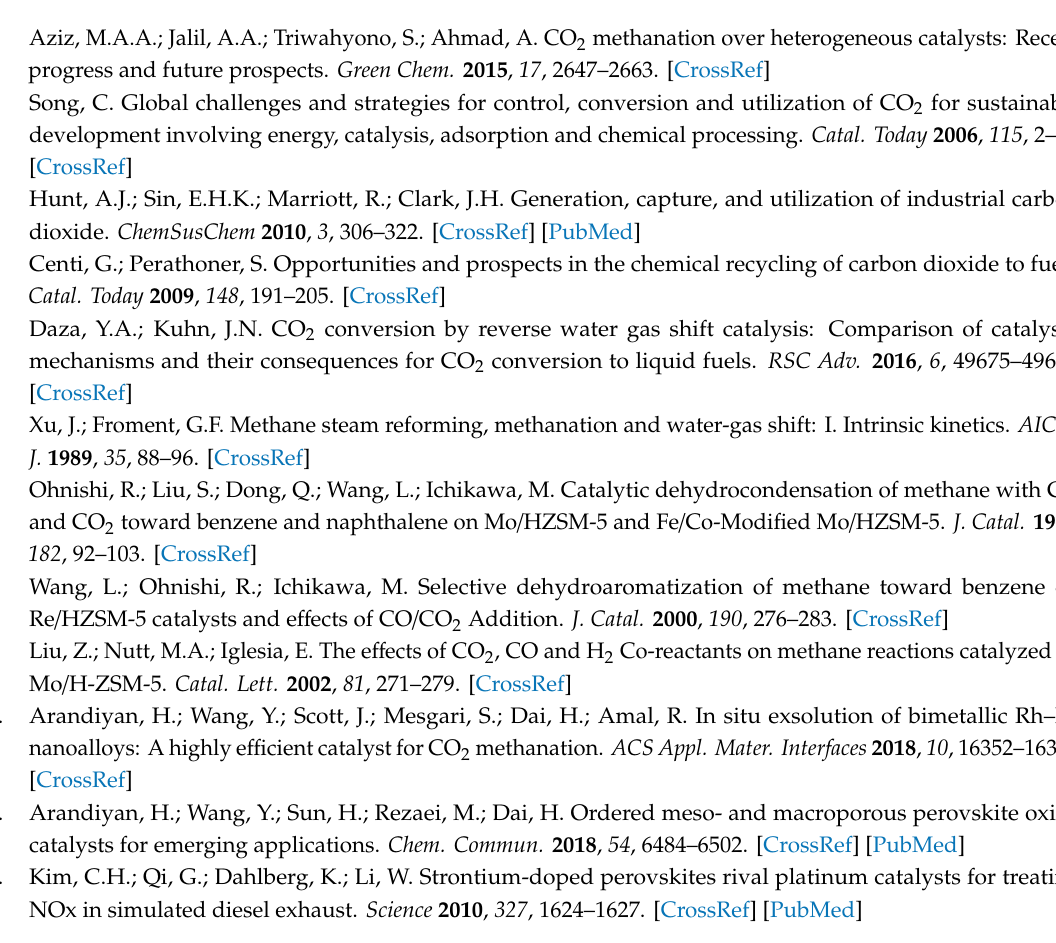
Figure S1: N 2 adsorption and desorption isotherms. Figure S2: Reduced sample TEM images. Figure S3: Spent sample Ni 2p XPS spectra. Figure S4: C1s XPS spectra. Figure S5: Catalyst activity and selectivity stability tests. Figure S6: Proposed catalytic mechanism on K-substituted LNO samples. Figure S7: Spent sample K 2p XPS spectra. Figure S8: Process flow diagram of reactor setup used for the catalytic